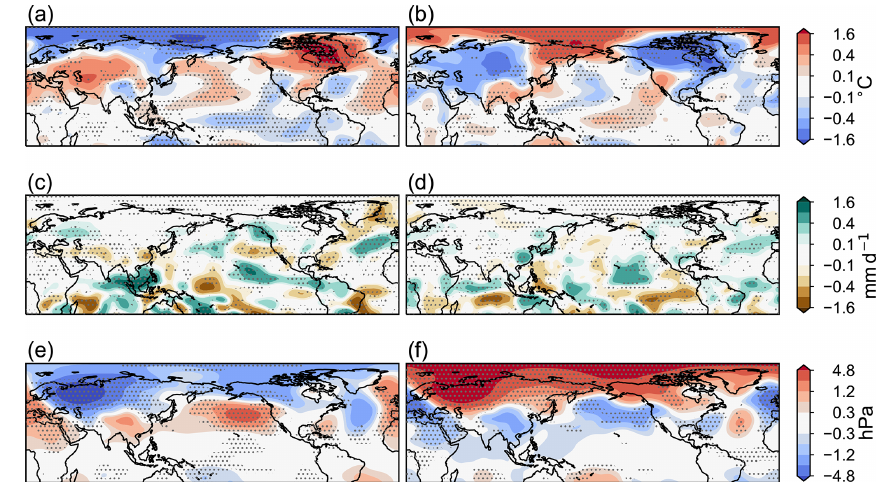
Figure 3. Spatial patterns of MEM anomalies in (a, b) near-surface air temperature, (c, d) precipitation rate and (e, f) sea-level pressure during JF (a, c, e) and MAM 2020 (b, d, f) . Subfigures (b) and (f) are shown as incremental changes (MAM minus JF). Stippling indicates where at least 70% of the models agree on the sign of